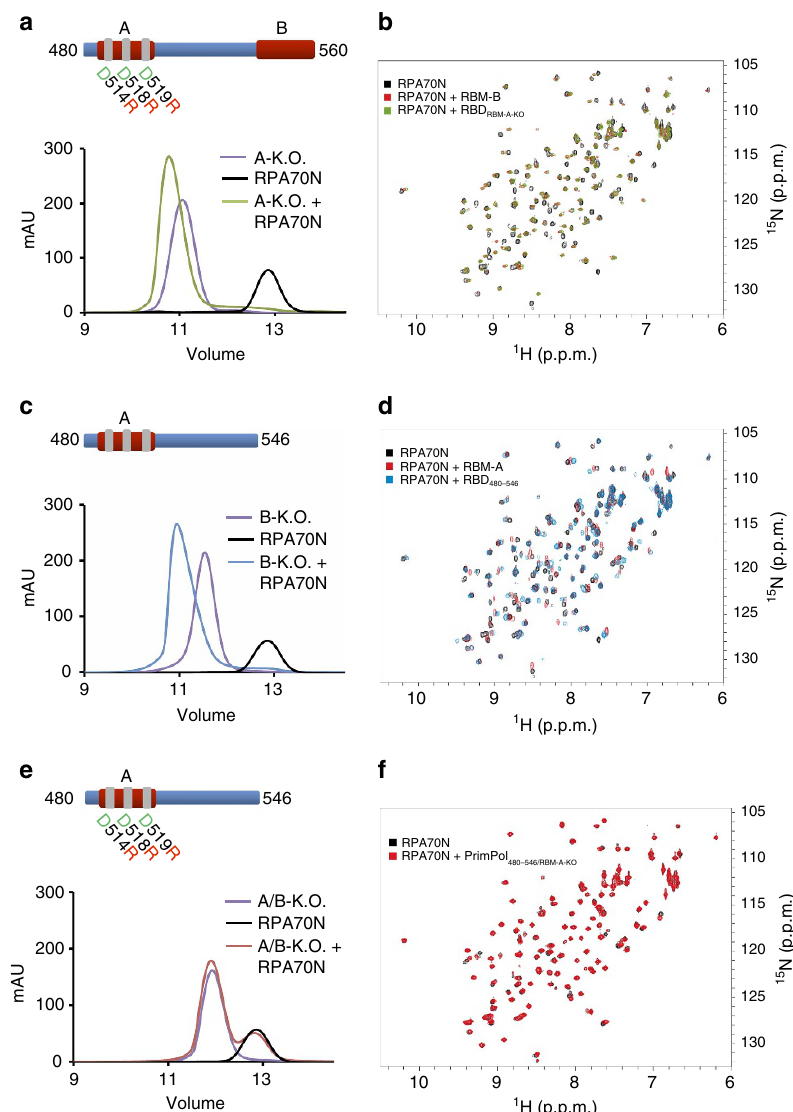
Figure 3 | RPA70N dynamically interacts with both RBM-A and RBM-B. ( a ) Mutation of RBM-A does not abolish binding of PrimPol’s RBD to RPA70N. Chromatographs showing the retention volumes of RBD A-KO (purple), RPA70N (black) and RBD A-KO with RPA70N in a 1:1 ratio (green). ( b ) 15 N- 1 H HSQC spectra showing RPA70N alone (black), in the presence of twofold molar excess of either RBD A-KO (green) or RBM-B peptide (residues 542–560) (red). The perturbations observed for RBD A-KO are similar to those induced by the RBM-B peptide. ( c ) Truncation of RBM-B does not prevent binding of PrimPol’s RBD to RPA70N. Chromatographs showing the retention volumes of RBD B-KO (purple), RPA70N (black) and RBD B-KO with RPA70N in a 1:1 ratio (blue). ( d ) 15 N- 1 H HSQC spectra showing RPA70N alone (black) or in the presence of twofold molar excess of RBD B-KO (blue) or RBM-A peptide (residues 510–528) (red). The perturbations observed for RBD B-KO are similar to those induced by the RBM-A peptide. ( e ) Mutation of both RBM-A and RBM-B abolishes the binding of PrimPol’s RBD to RPA70N. Chromatographs showing the retention volumes of RBD A/B-KO (purple), RPA70N (black) and RBD A/B-KO with RPA70N in a 1:1 ratio (red). ( f ) 15 N- 1 H HSQC spectra showing RPA70N alone (black) or in the presence of twofold molar excess of RBD A/B-KO (red). The near identity of the two spectra indicates there is no